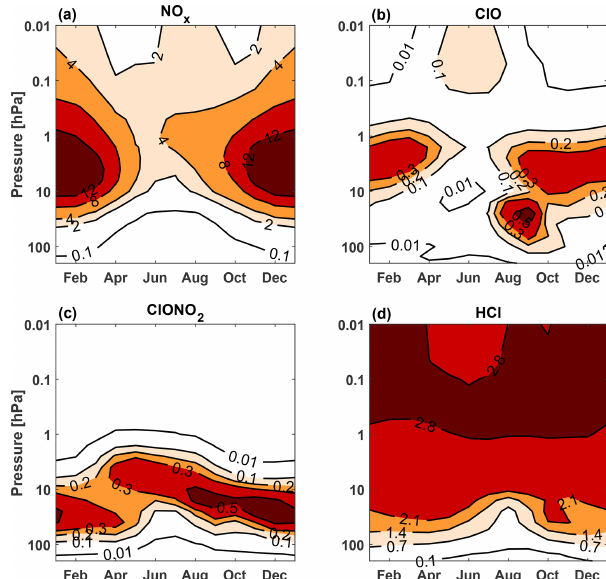
Figure 6. (a) Seasonal climatology of NO x in the Antarctic (70– 90 ◦ S, 0.01–200hPa) during 1979–2008. Positive contour levels are 0.1, 2, 4, 8 and 12ppb. Seasonal climatology for (b) ClO and (c) ClONO 2 are shown with positive contour levels of 0.01, 0.1, 0.2, 0.3 and 0.5ppb, and for (d) HCl with positive contour levels of 0.1, 0.7, 1.4, 2.1 and 2.8ppb. All figures are calculated using the REF simulation, i.e. without the EPP